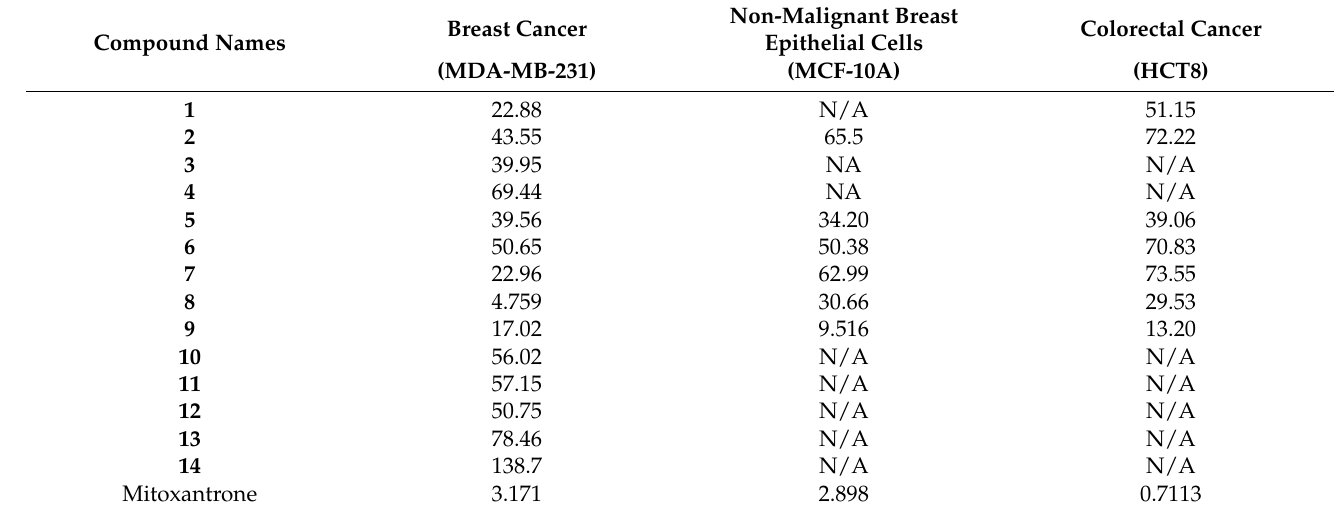
Table 1. The IC 50 ( µ M) of nitrogen-based derivatives against cancer cell lines using MTT assay.